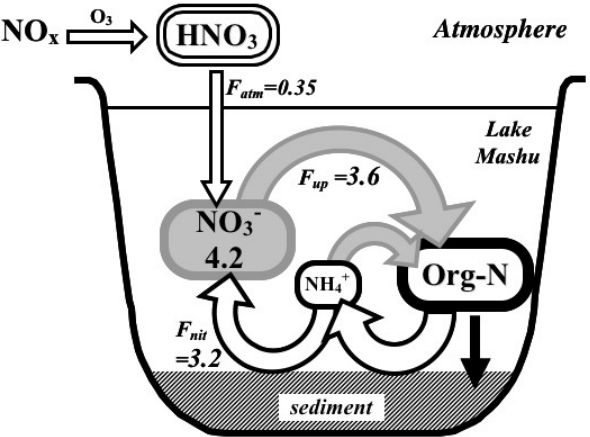
Fig. 6. Schematic diagram showing the nitrate cycling dynamics in Lake Mashu. The magnitude of the nitrate reservoir in June is presented (unit: Mmol), together with the estimated annual fluxes between each reservoir (unit: MmolNa − 1 )